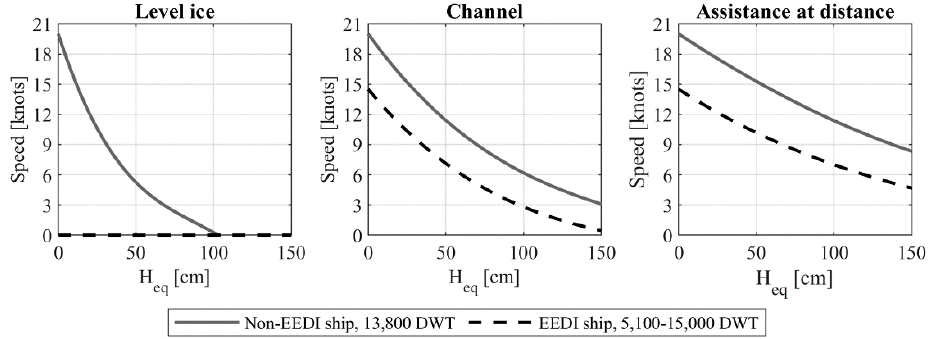
Figure 10. Example comparison of the assumed speed in ice of a non-EEDI ship and an EEDI-compliant ship [26].